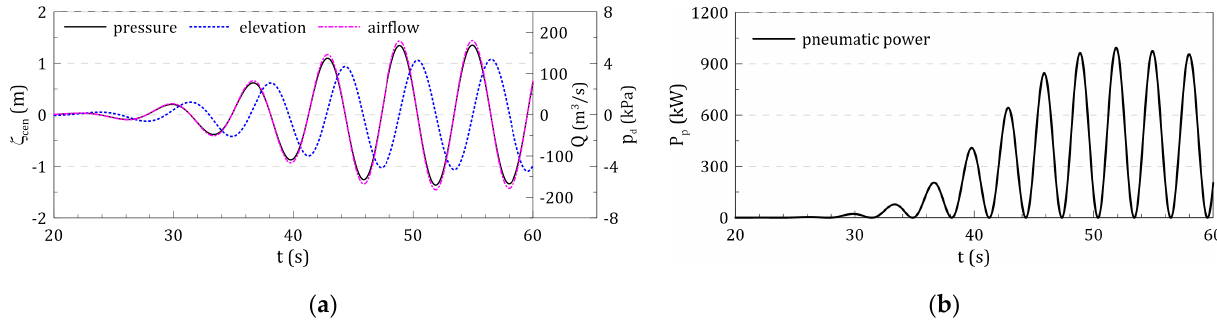
Figure 12. Example of time-series data measured at the OWC chamber under the wave excitation simulation with direct interaction method: ( a ) free-surface elevation, airflow, and pressure drop; ( b ) pneumatic power.